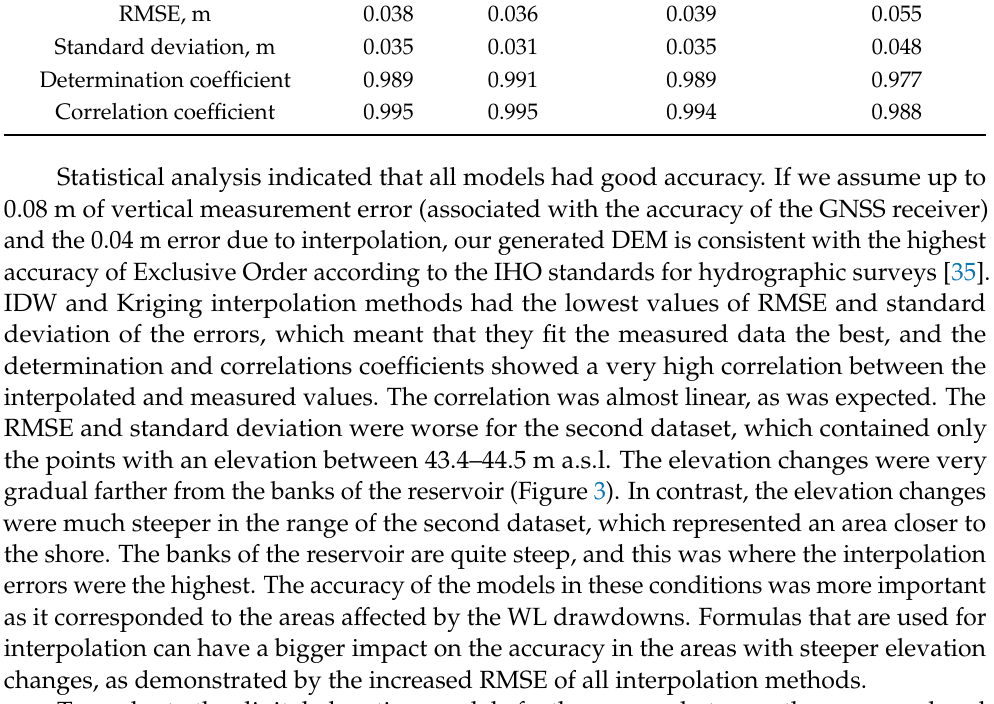
Table 2. Results of the statistical analysis of the generated digital elevation models.